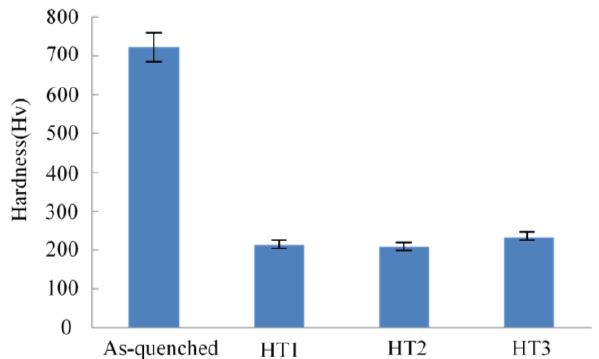
Figure 8. Microhardness of modified 440A MSS under various heat treatment processes.